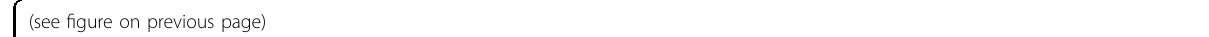
Fig. 2 Cell death induction by single-dose ionizing radiation in cells with altered cell death pathways. a – d Cell death and caspase activity were measured 72 h after IR at the indicated doses by Sytox Green and Ac-DEVD-amc fl uorescence in MLKL + / + L929sA ( a ), MLKL − / − L929sA ( b ), MLKL + / + MEF ( c ), MLKL − / − MEF cells ( d ), Bax/Bak + / + MEF ( e ), and Bax/Bak − / − MEF ( f ), ACSL4 + / + Pfa1 ( g ), and ACSL4 − / − Pfa1 ( h ). When indicated, the cells were pre-treated for 1 h with zVAD-fmk, Nec1s or Fer-1, or a combination thereof. Histogram bars show Sytox Green positivity and lines indicate caspase activity (fold induction). Means ± SEM are shown ( n = 2 – 3). A two-way ANOVA was performed with a Tukey ’ s multiple comparisons test. Asterisk (*) shows the comparison to 0 Gy DMSO. Hash (#) shows the comparison to the DMSO treatment for the respective irradiation dose. *, # p ≤ 0.05, ## p ≤ 0.01, ***, ### p ≤ 0.001, ****, #### p ≤